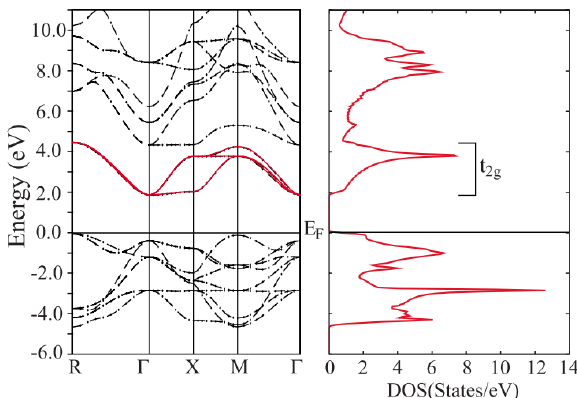
Figure 6. The band structure and the density of states of SrTiO 3 [80]. Copyright 2010, Physical